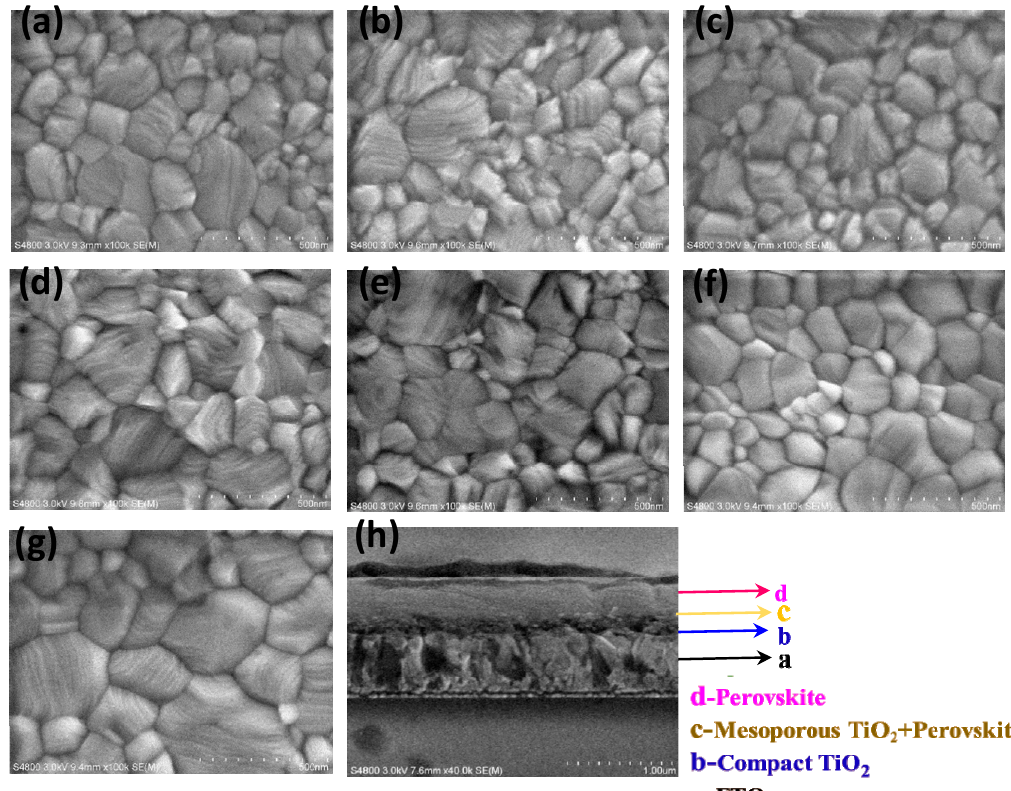
Figure 2. Top-view SEM images of perovskite films on smooth FTO/( a – f ): 0, 5 wt.%, 6.7 wt.%, 10 wt.%, 20 wt.% and 33.3 wt.% of Ag NPs in c-TiO 2 layer/m-TiO 2 layer; and ( g ) Top-view SEM image of perovskite film on T-FTO/10 wt.% Ag NPs in c-TiO 2 layer/m-TiO 2 layer; ( h ) Cross-sectional SEM image of perovskite film on T-FTO/ 10 wt.% Ag NPs in c-TiO 2 layer/m-TiO 2 layer.